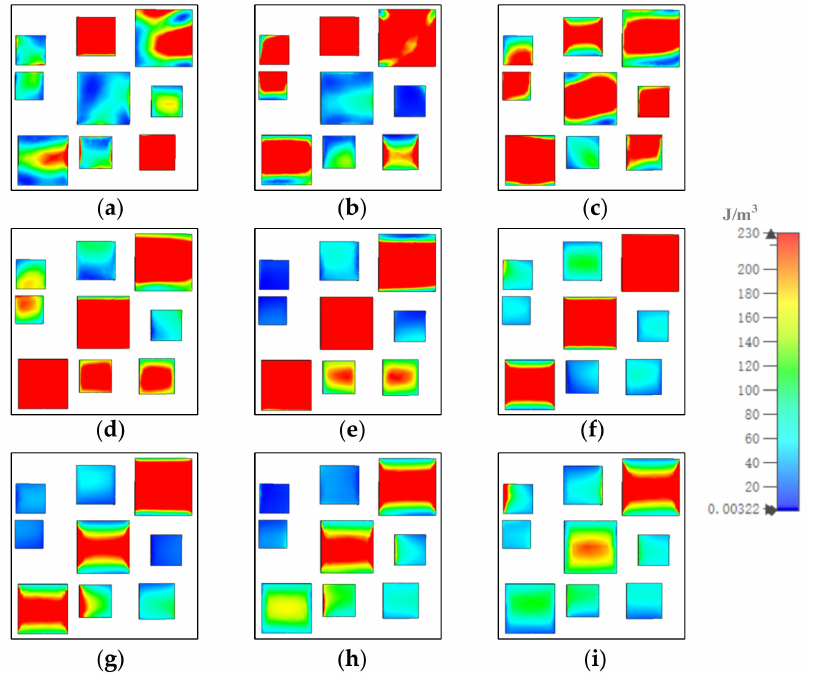
Figure 9. The distribution of magnetic field energy in middle gold layer at ( a ) 8.5, ( b ) 9.13, ( c ) 9.88,